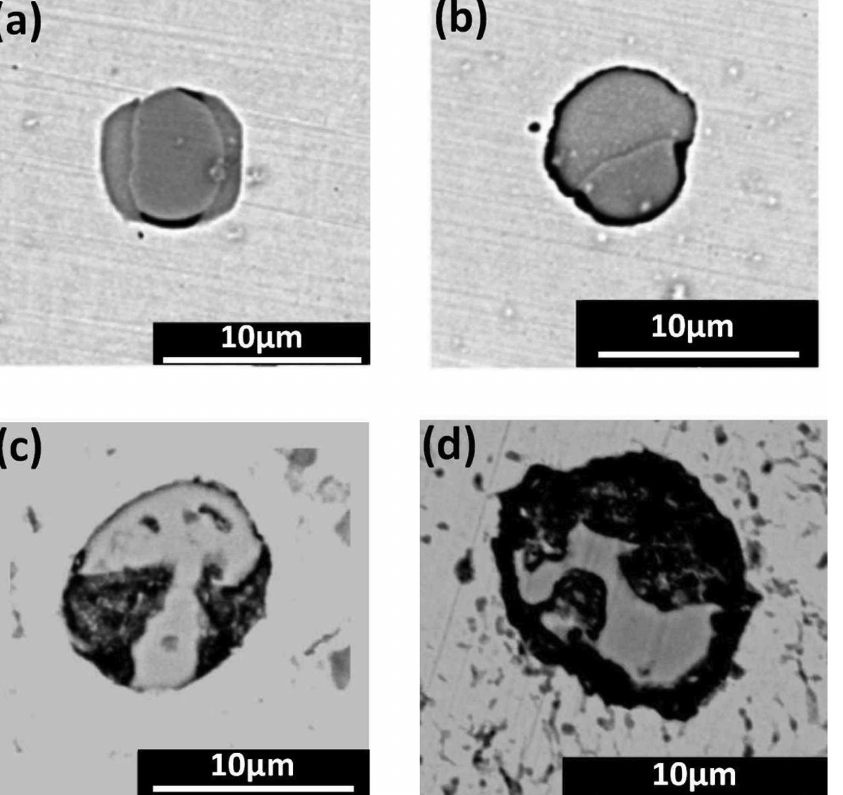
Figure 6: SEM images of four different pitting corrosion morphologies. (a) Sulfide inclusion surrounding matrix partly dissolved. (b) Sulfide inclusion surrounding matrix totally dissolved. (c) The interior of sulfide inclusion dissolved. (d) Both interior and surrounding matrix dissolved.